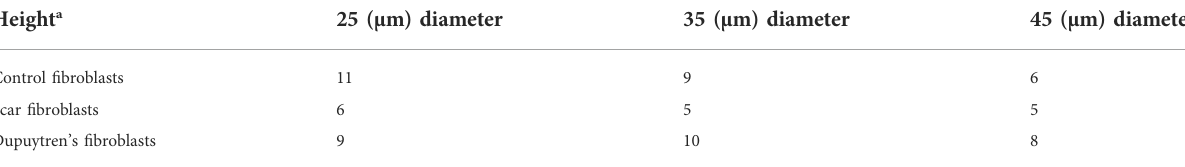
TABLE 1 Cell height when patterned in the different circular-shaped diameters.